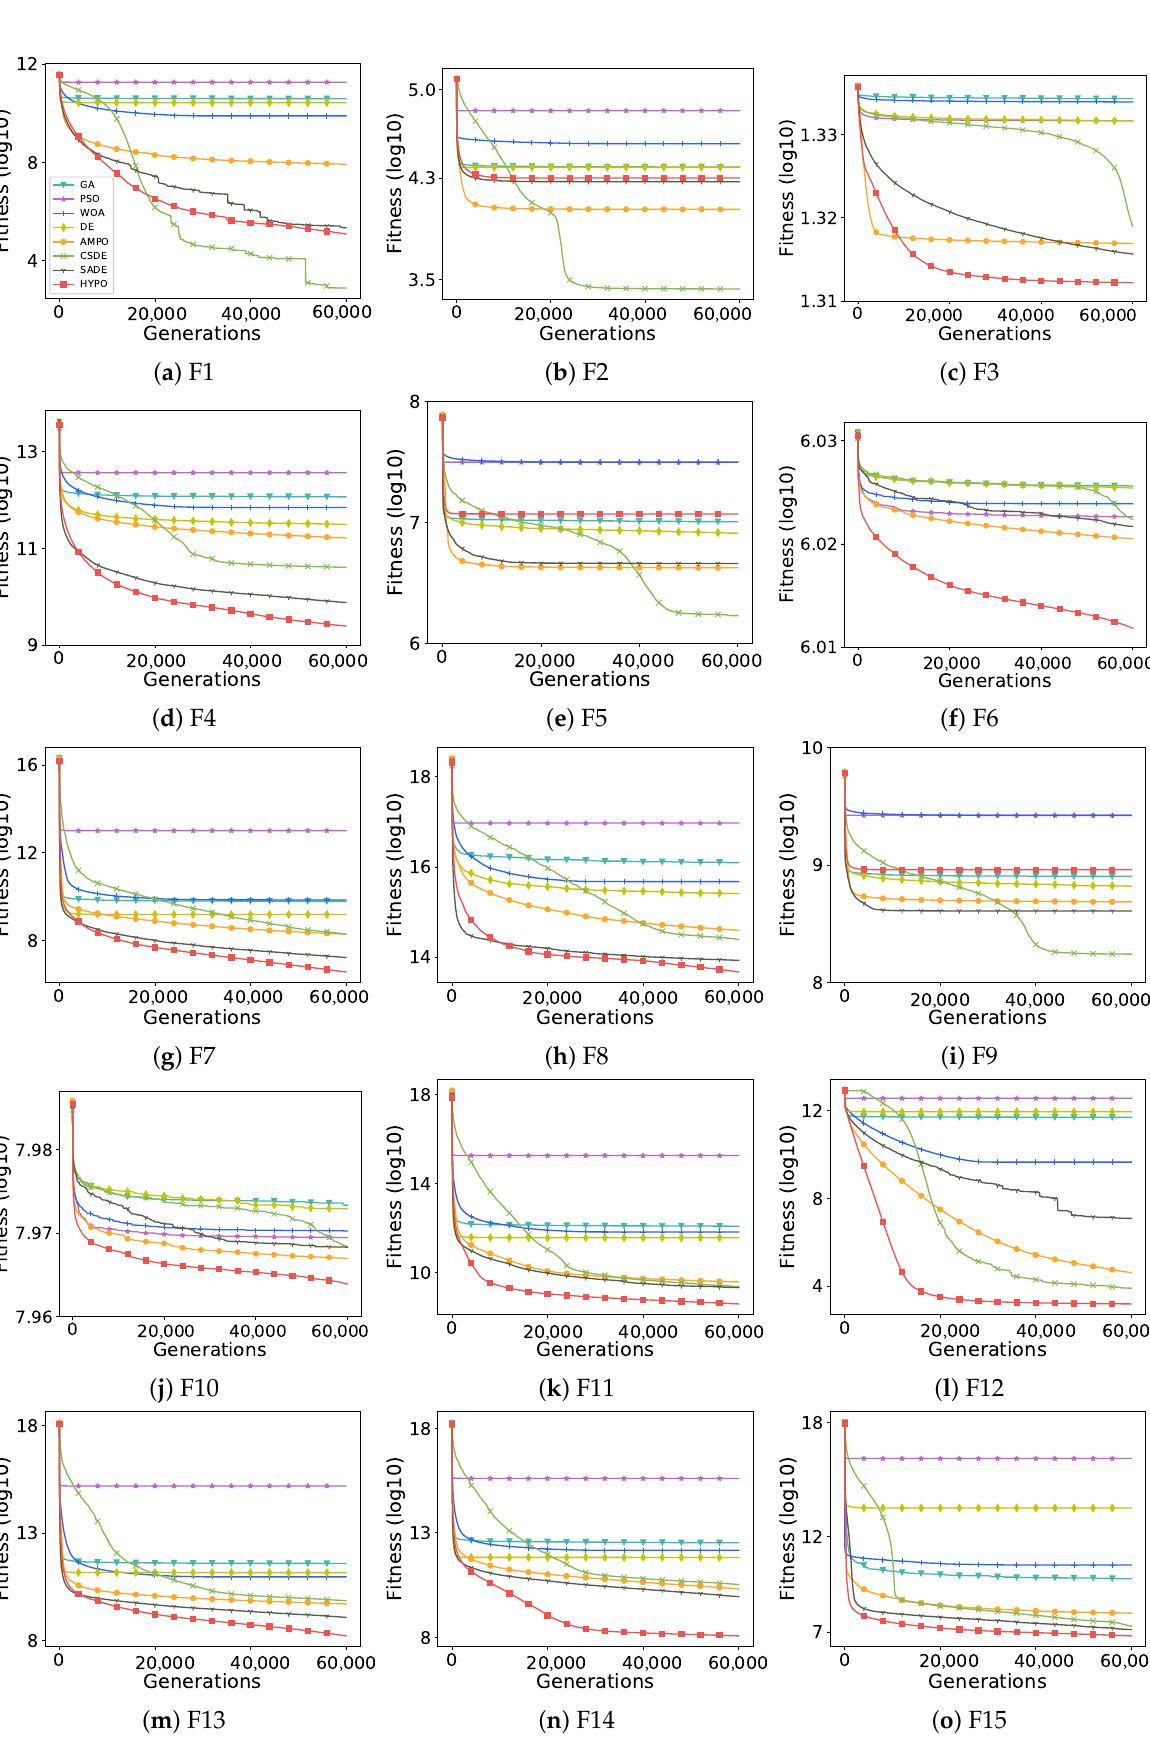
Figure 4. The Comparison of the Convergence on the CEC2019